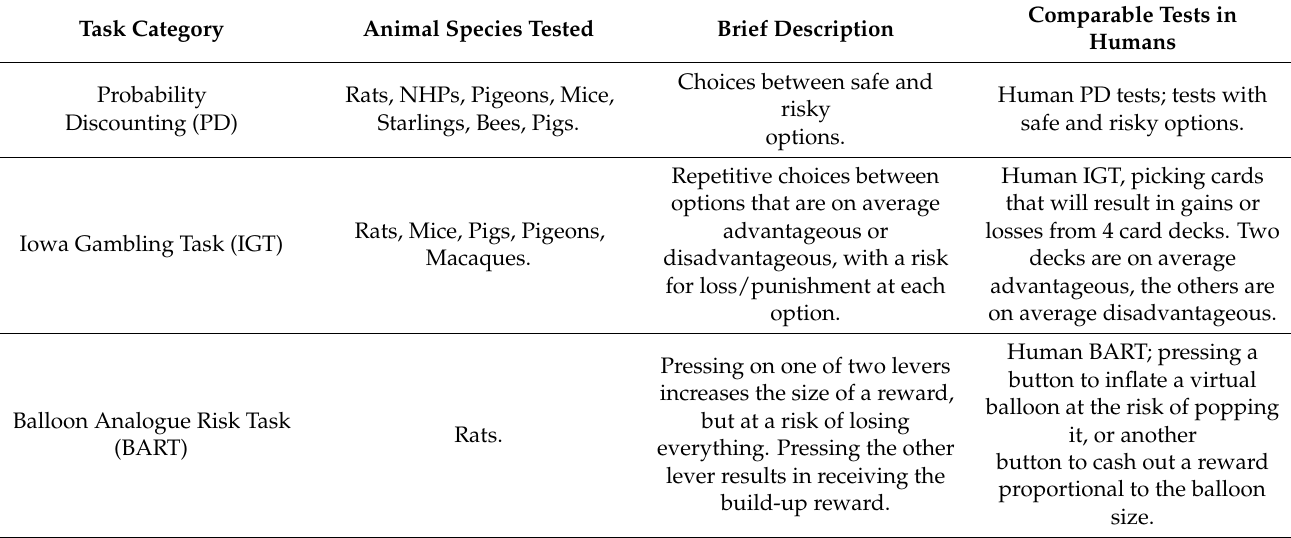
Table 1. Summary of task